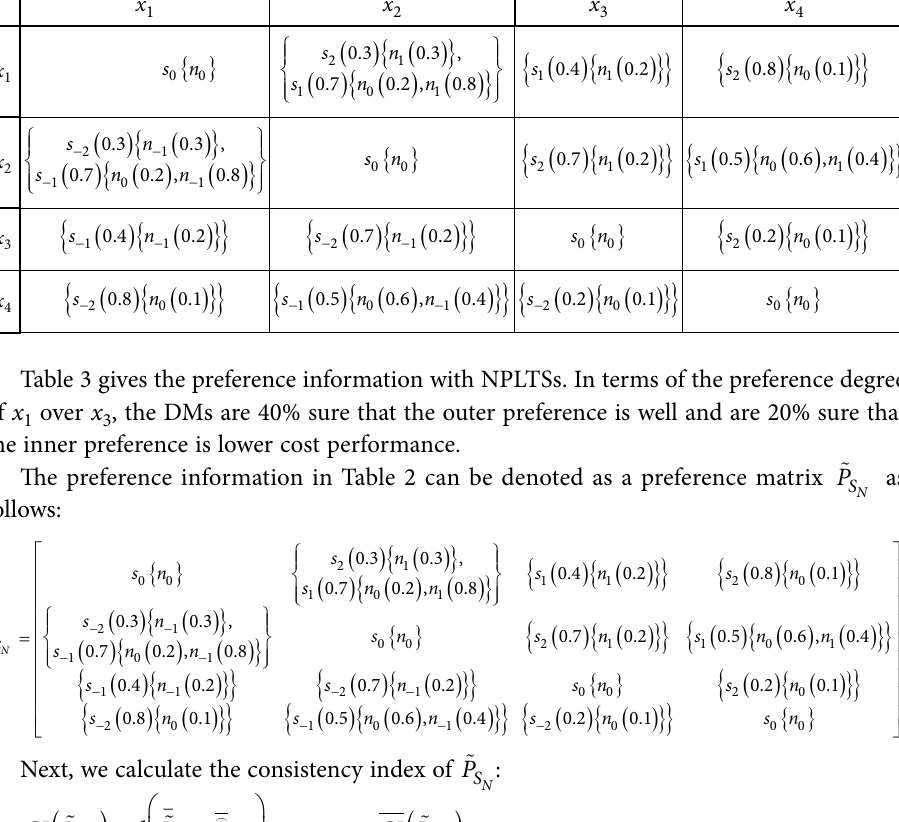
Table 3. The preference information with NPLTSs between project plans (source: our research) x 1 x 2 x 3 x 4 x